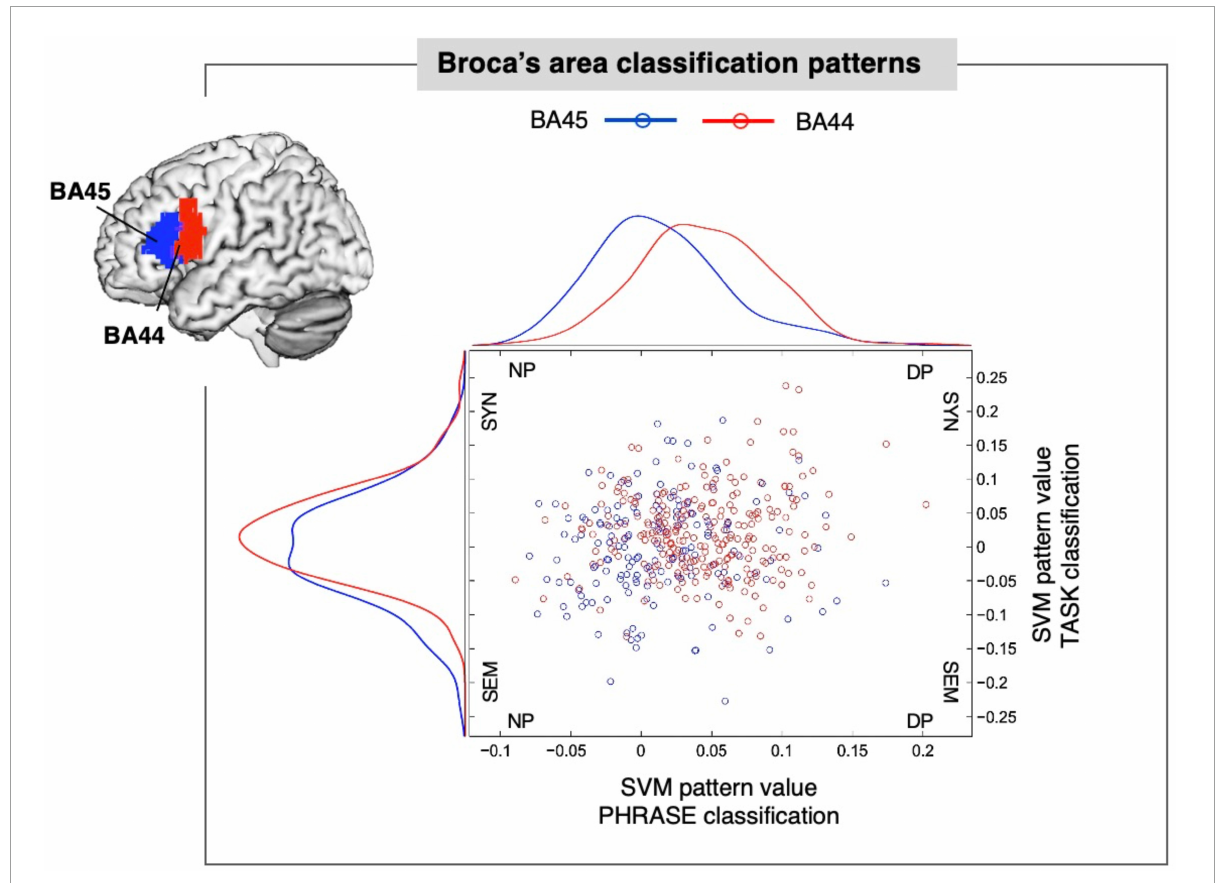
FIGURE2 Broca’s area classification patterns. SVM (support vector machine) pattern values within the anatomically defined Brodmann Area (BA) 44 and BA45 of Broca’s area (top-left), expressing positive and negative distances of each voxel from the separating hyperplane for PHRASE and TASK. Blue dots represent voxels located in BA45. Red dots represent voxels located in BA44. Curves represent pattern distribution for PHRASE and TASK in BA44 and BA45, respectively. SYN, syntax; SEM, semantics; NP, noun phrase; DP, determiner phrase. Figure created using the Multi-Image Analysis GUI viewer (Mango, Version 4.1; http://ric.uthscsa.edu/mango/) and MATLAB 7.14.0.739 (R2012a, Mathworks, Inc., Sherborn, MA,